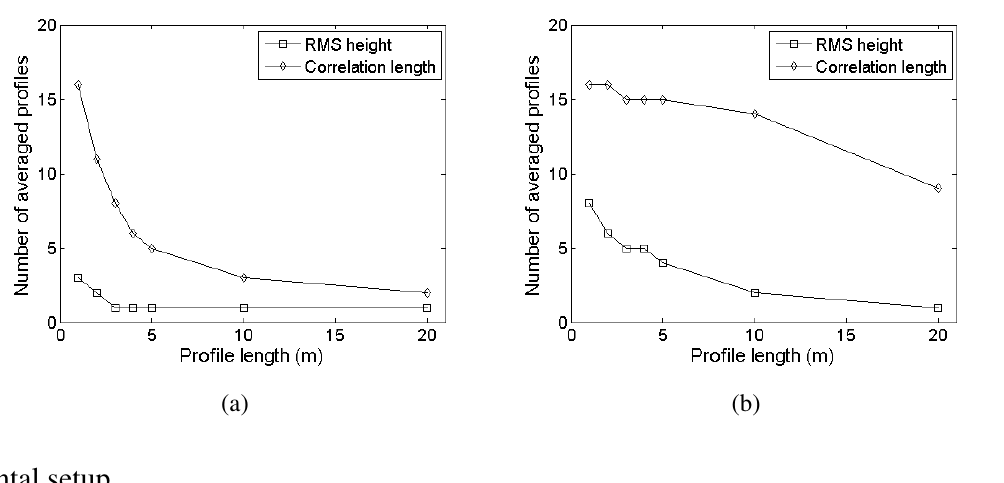
Figure 8. Number of profiles required to obtain a standard deviation of RMS height or correlation length less than 10% of the mean for different profile lengths. Sampled profiles originate from large profiles with ( s , l ) equal to (a) (1 cm,5 cm) and (b) (1 cm,40